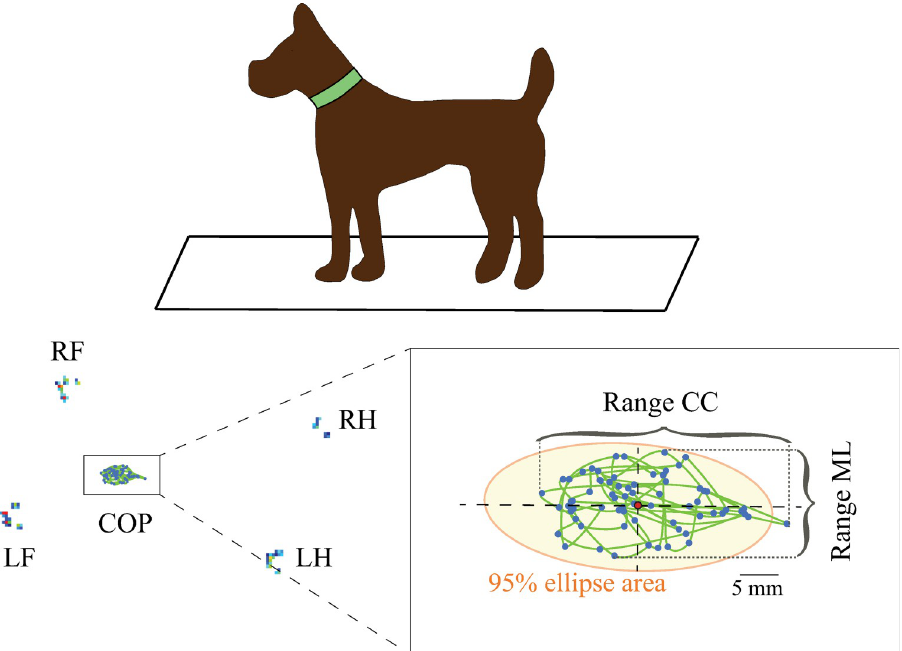
Fig 1. COP displacement evaluation in dogs. Top: Schematic representation of a dog standing still on a pressure sensitive walk-way system. Left Bottom: Location of each limb and COP trajectory during one trial. Right Bottom: Magnification of the COP trajectory. Blue dots represent the location of the COP at each frame, and the red dot represents the centroid or Mean COP. The brackets correspond to the range in the CC and ML directions and the orange ellipse represents the 95% ellipse area of the